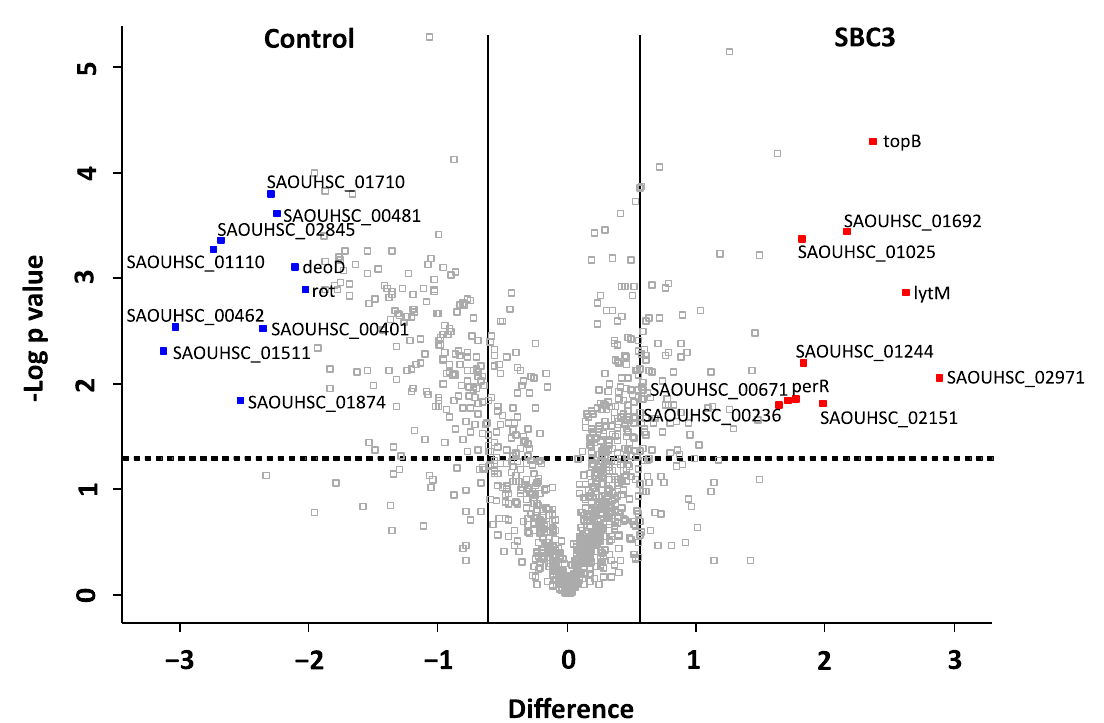
Figure 5. Volcano plot generated from a two-sample t -test ( p < 0.05) of S. aureus treated with SBC3 (12 μg/mL) versus untreated control samples. All identified and filtered proteins are displayed based on p value (-log10 p value) on the y -axis and fold change (log 2 mean LFQ intensity difference) on the x -axis. Statistically significant ( p < 0.05) proteins are positioned above the horizontal, dashed line, and proteins with a fold change of ≥1.5 are to the right and left of the vertical lines. The top ten most differentially abundant proteins are highlighted and annotated with gene names, which are listed in Table 2, and including the protein products, functions and fold change. Table 2. The top 20 most differentially abundant proteins identified in S. aureus treated with SBC3.